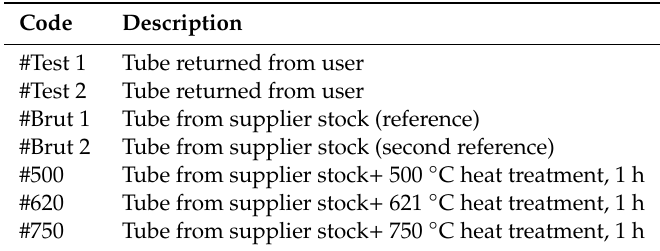
Figure 3. Procedures of single loop EPR test method according to ASTM G108–94 (2015) [48]. The samples tested were tubes of 304L AISI, used for manufacturing medical endoscopes (Table 5). The tubes #Test 1 and #Test 2 were suspected to be sensitized in intergranular corrosion. For the evaluation test, reference samples #Brut 1 and #Brut 2 and three samples from the supplier stock, subjected to heat treatments at 500, 620 and 750 °C, respectively, were used (Table 5). Table 5. Test samples #1, 14306/304L tubes.